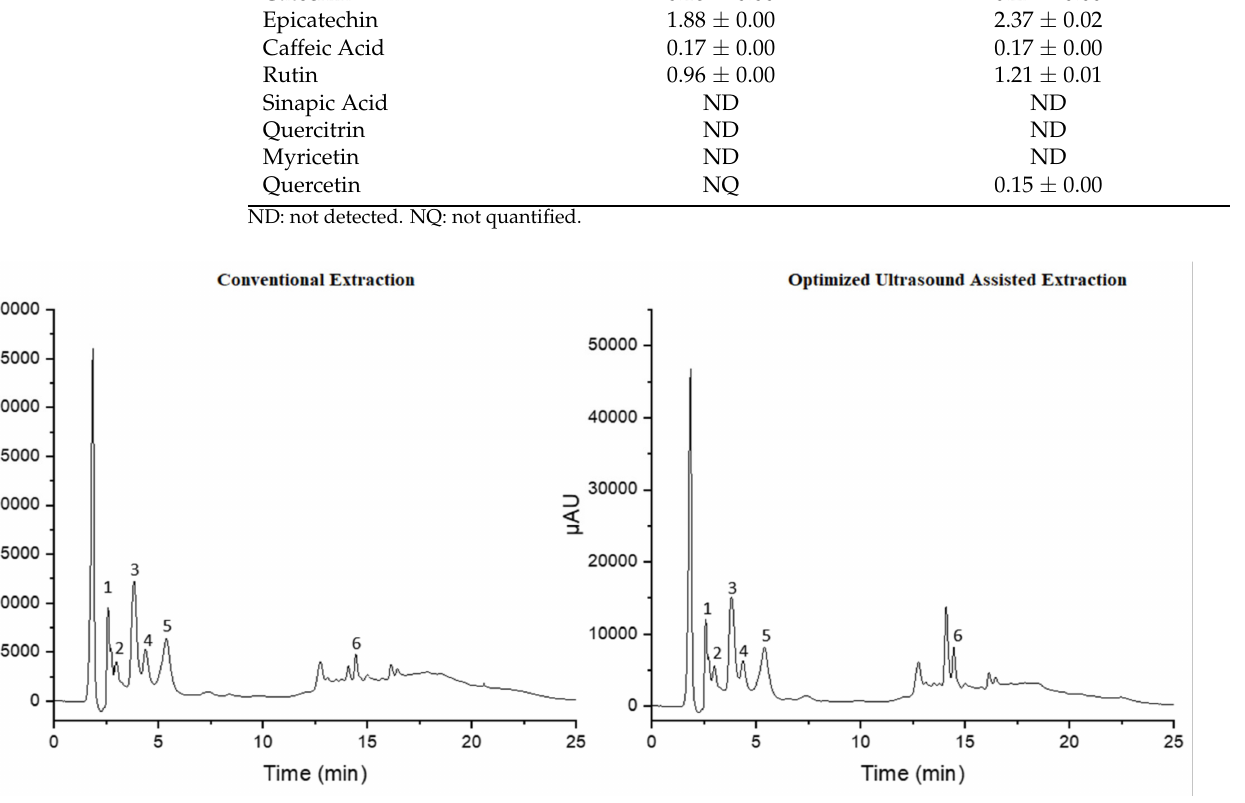
Figure 4. HPLC chromatograms of phenolic compounds for extracts obtained by conventional extrac- tion and ultrasound-assisted extraction under the optimum conditions. (1) Gallic acid, (2) catechin, (3) epicatechin, (4) Caffeic Acid, (5) Rutin and (6)